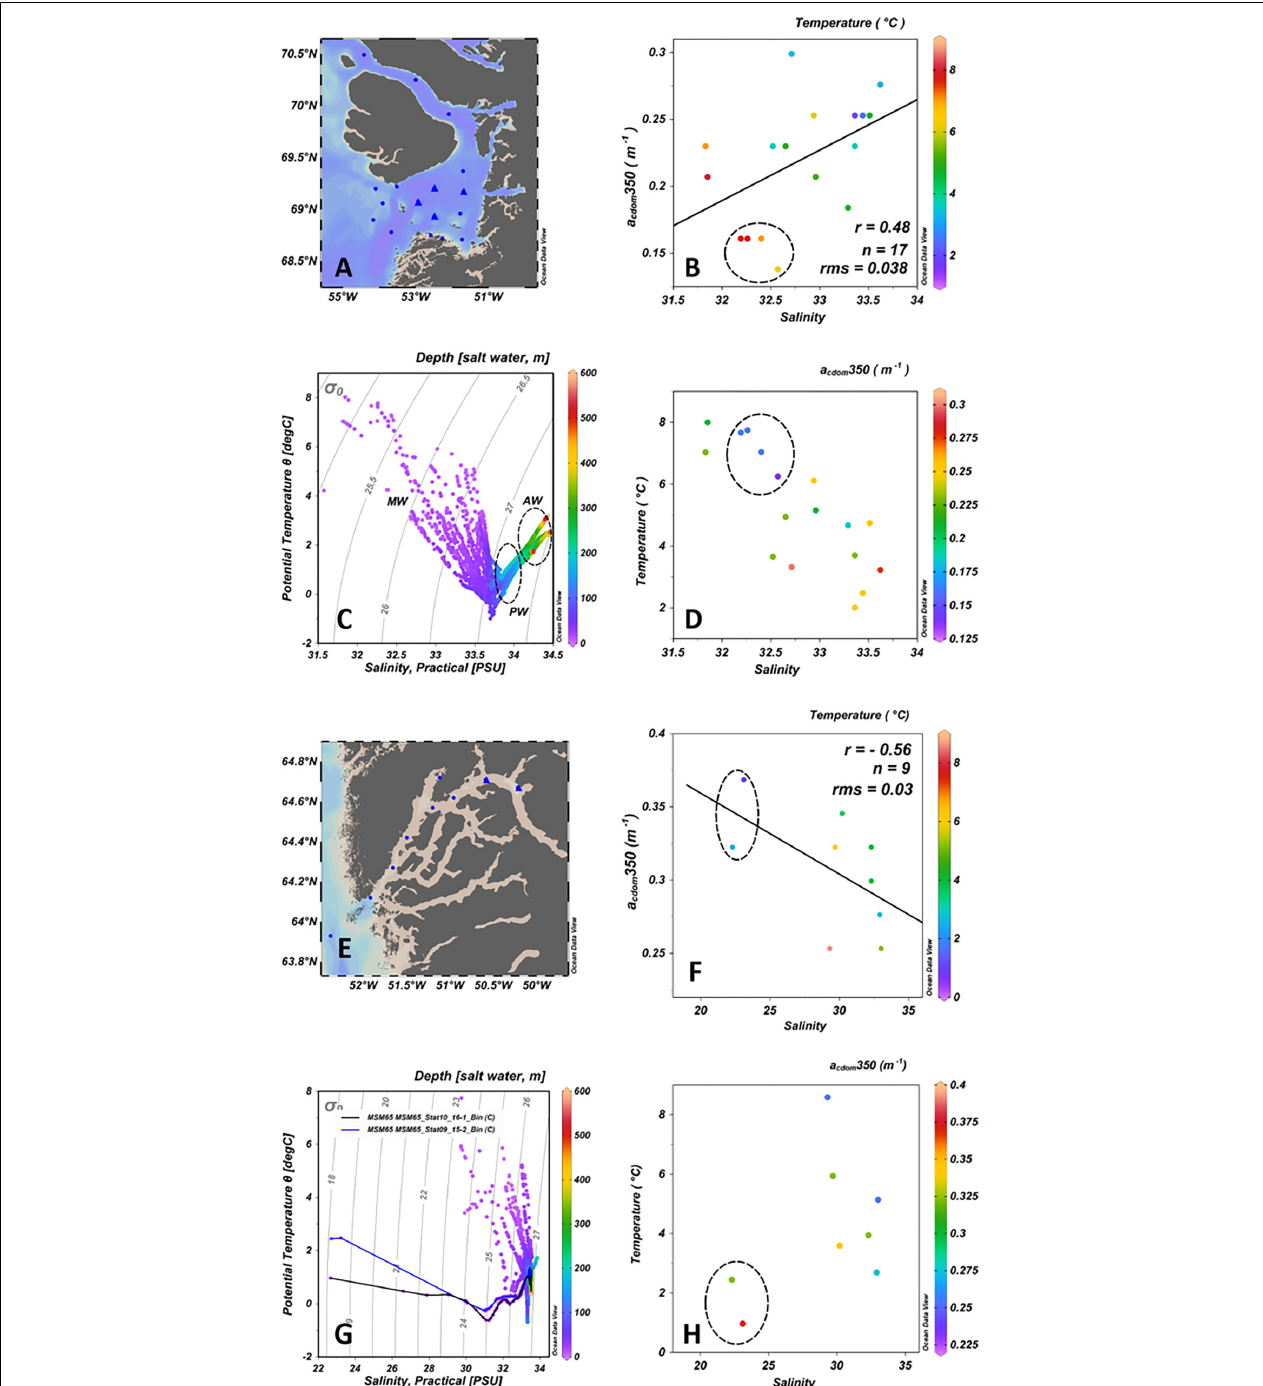
FIGURE 4 | TS Plots and water masses in the (top panel) Vaigat-Disko Bay and (Bottom panel) Godthabsfjord. (A,E) Stations sampled in the Vaigat-Disko Bay and Godthabsfjord, meltwater core stations marked as triangles. (B,F) Regression of Salinity vs. a cdom 350 ( r , correlation coefficient; n , number of data points; rms, root mean square). Color represents temperature as indicated in the colorbar. Data points enclosed in dashed circle represent meltwater core stations. (C,G) Scatter plot of salinity and potential temperature with isopycnals. Color represents depth as indicated in the colorbar. (D,H) Scatter plot of salinity and temperature. Color represents a cdom 350 as indicated in the colorbar. Data points enclosed in dashed circle represent meltwater core stations. Note that ranges in axes are different, representing the observed ranges in different parameters in the two areas of